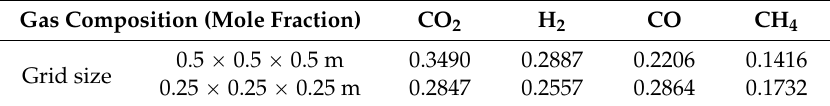
Figure 48. Effect of the grid size on the temperature distribution: large grids (left) and small grids (right) (reproduced from Nourozieh et al. [12]). Table 21. Effect of the grid size on product gas composition [12].